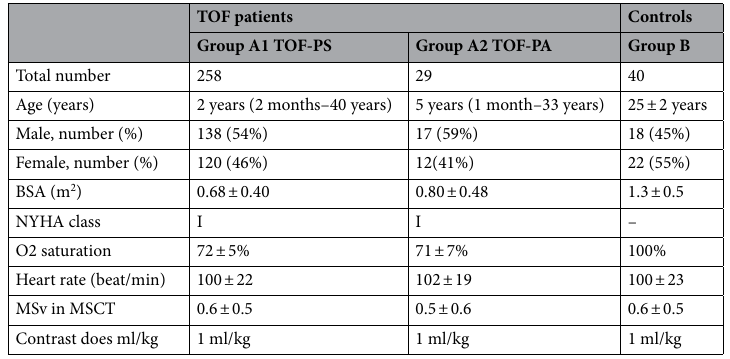
Table 1. Demographic data of the study cohort.